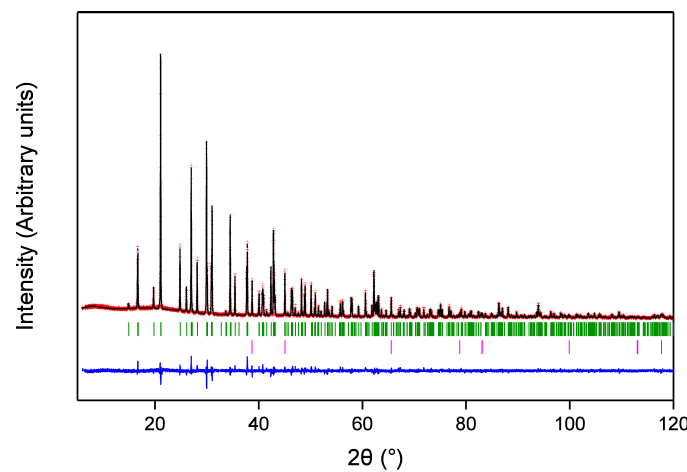
Figure 4. Rietveld fit of BaZn(NCN) 2 to PXRD data, showing calculated ( black ), observed ( red ), and difference ( blue ) intensities. Bragg reflections for BaZn(NCN) 2 and LiF are denoted by green and pink vertical markers, respectively. Table 2. Crystallographic data and fractional coordinates (all atoms on 8 c ) for BaZn(NCN) 2 . Standard deviations are given in parentheses.